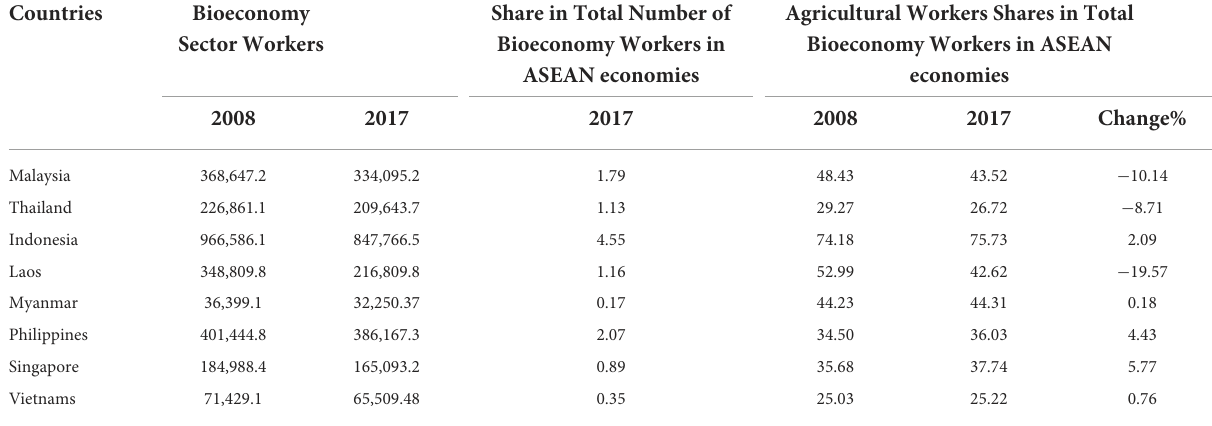
TABLE 2 Agriculture shares of ASEAN